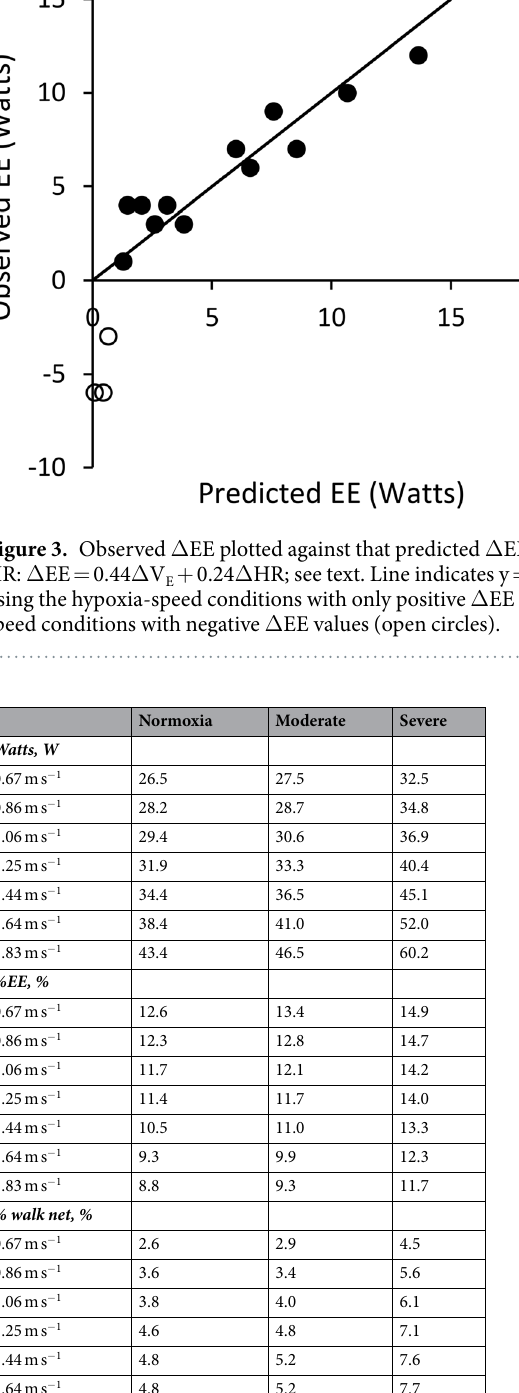
Table 2. Mean values of EE, the percentage EE to total cardiopulmonary work, and the percentage of net cardiopulmonary EE at rest and each walking speed under all